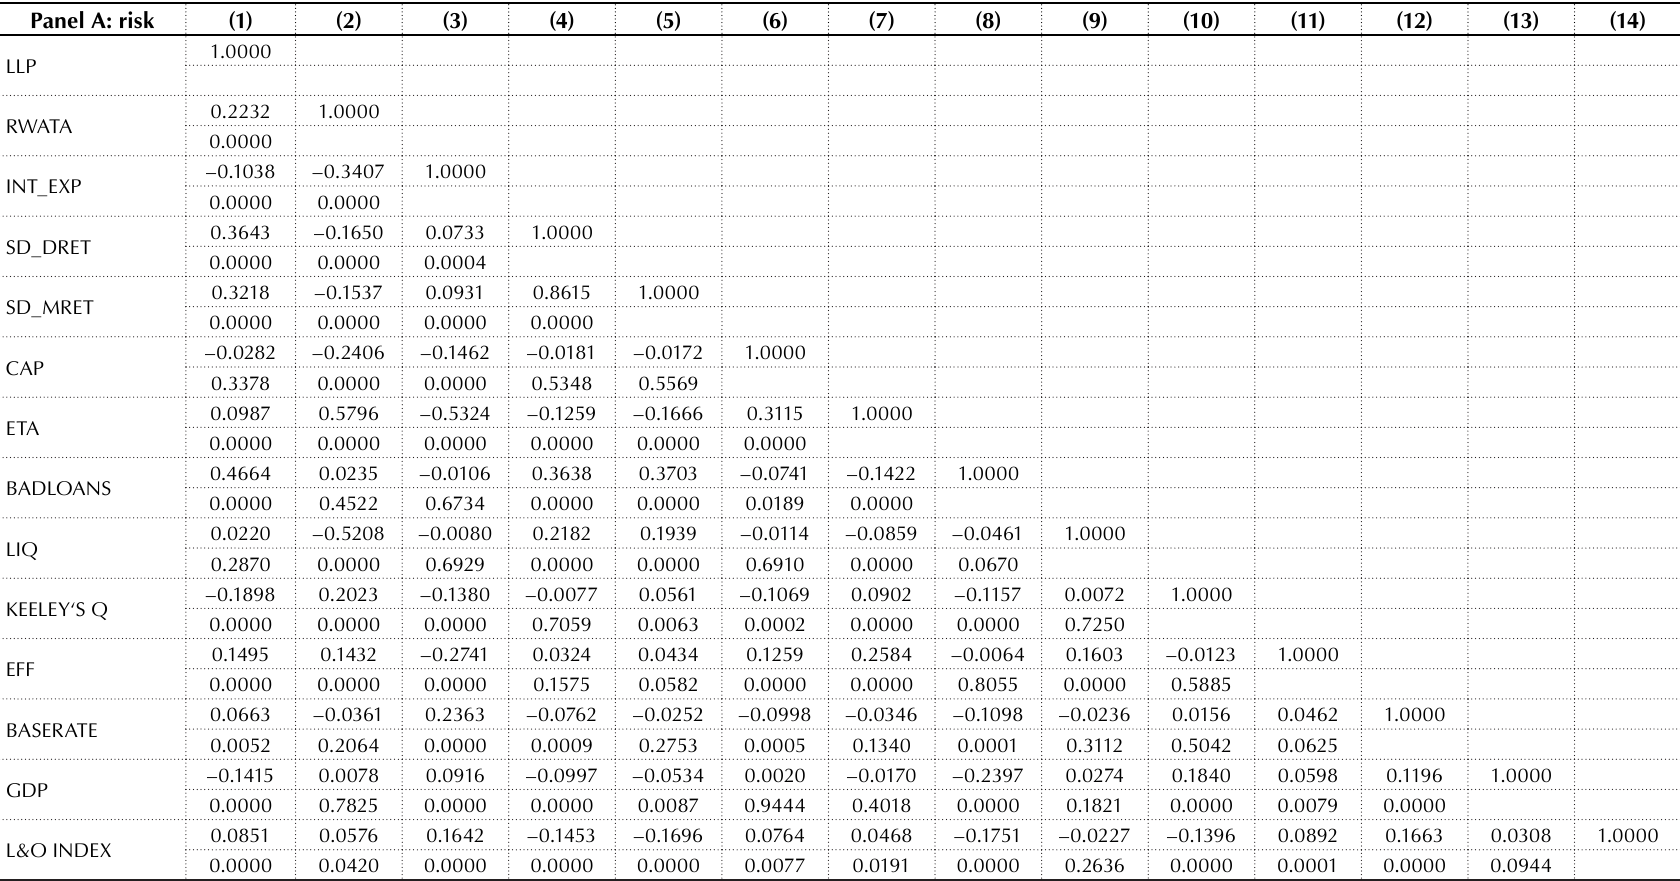
Table 5. Correlation matrix of risk and profitability regression